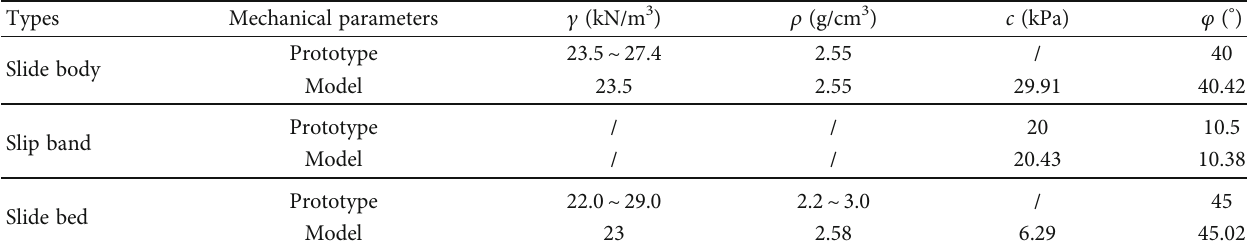
Table 1: Physical and mechanical parameters of prototype and model landslides.